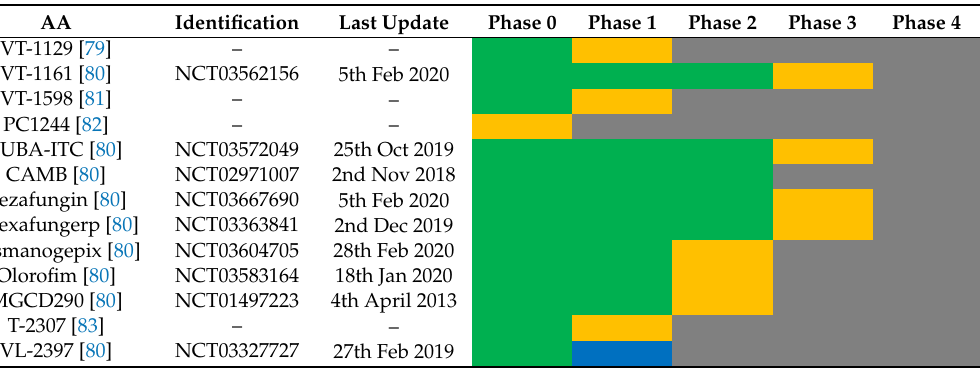
Table 6. Complete (green), ongoing (orange), terminated (blue), and not yet realized (gray) phases of clinical trials of new promising antifungals. More details about these drugs are in the following text. AA = antifungal